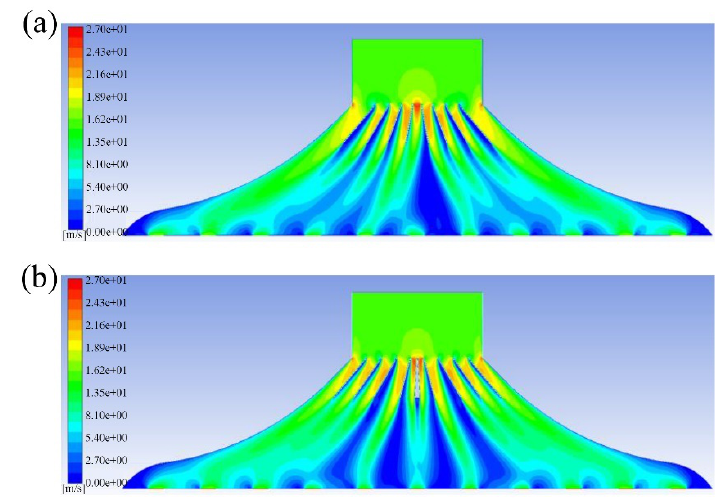
Figure 9. Velocity distribution in the header with different number of splitter plates: ( a ) n = 8; ( b ) n = 9.